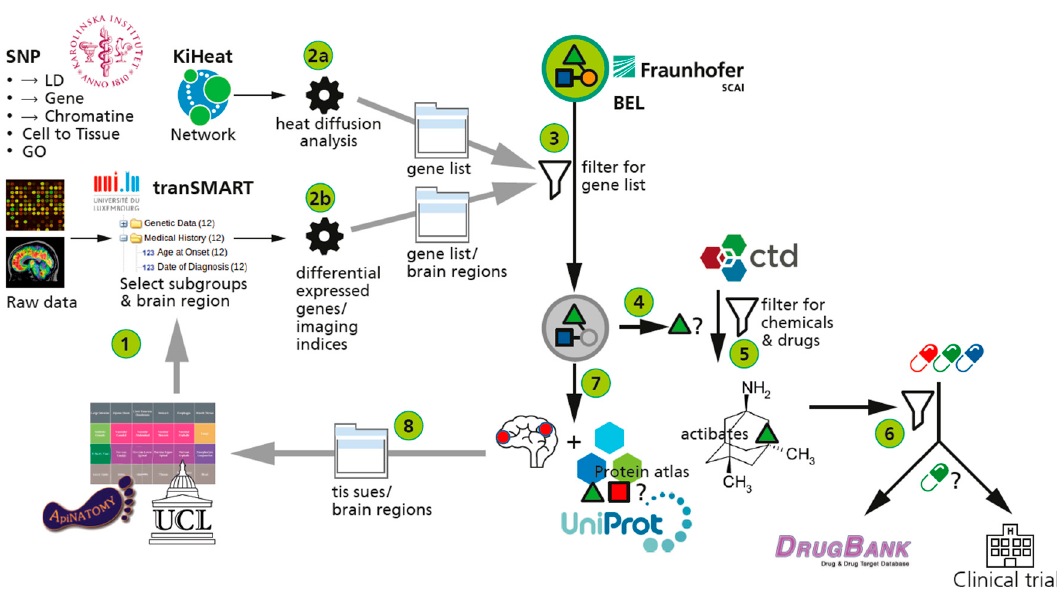
Figure 6. Workflow for candidate mechanism identification in the AETIONOMY Knowledge Base—the Parkinson Disease example. represent BEL ans SBML models; represents the gene component of the model. represents the protein component.